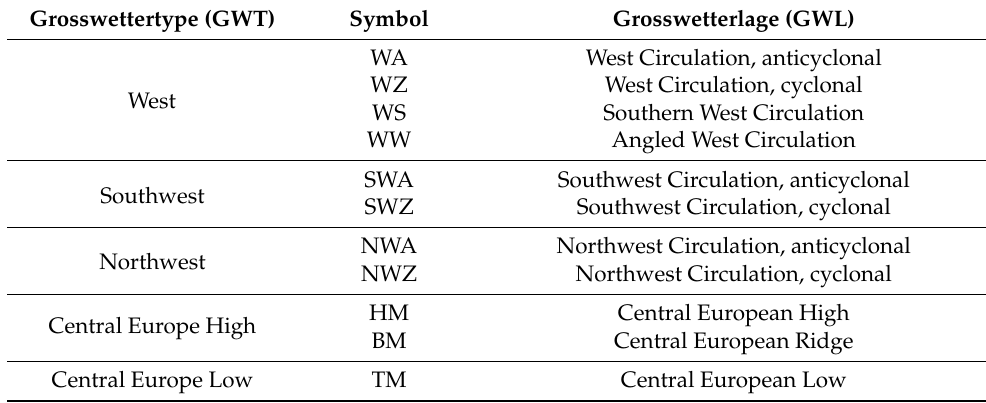
Table 2. Types of Grosswetterlagen circulation